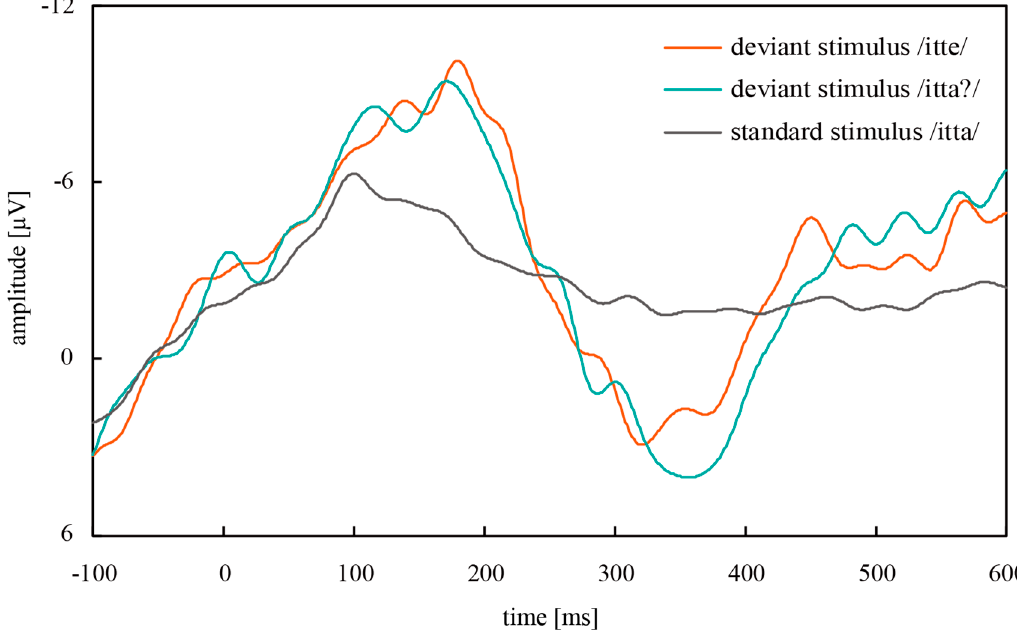
Figure 9. Grand mean waves measured at Cz from the ERPs measured at the parietal region of all participants in the oddball task.